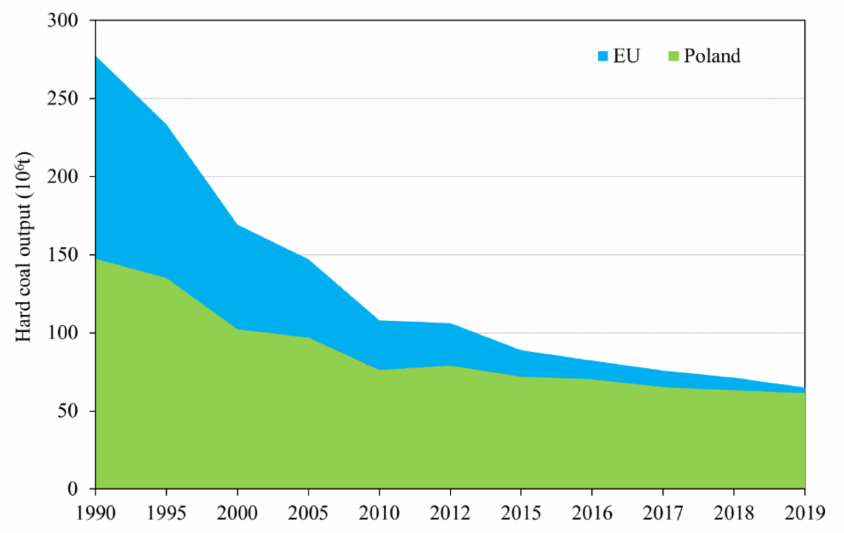
Figure 1. Hard coal output in Poland and the European Union in the years 1990–2019 according to [4,7].